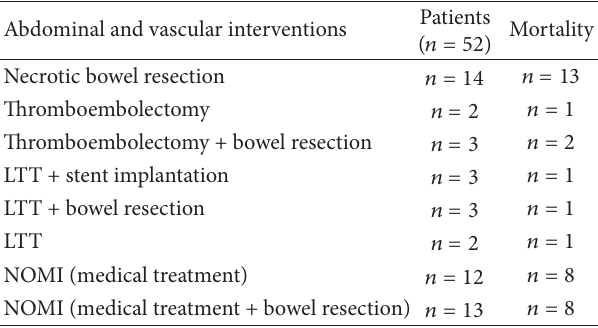
Figure 2: Intraoperative image of a gangrenous and necrotic bowel. Table 3: Abdominal and vascular interventions on patients with intestinal